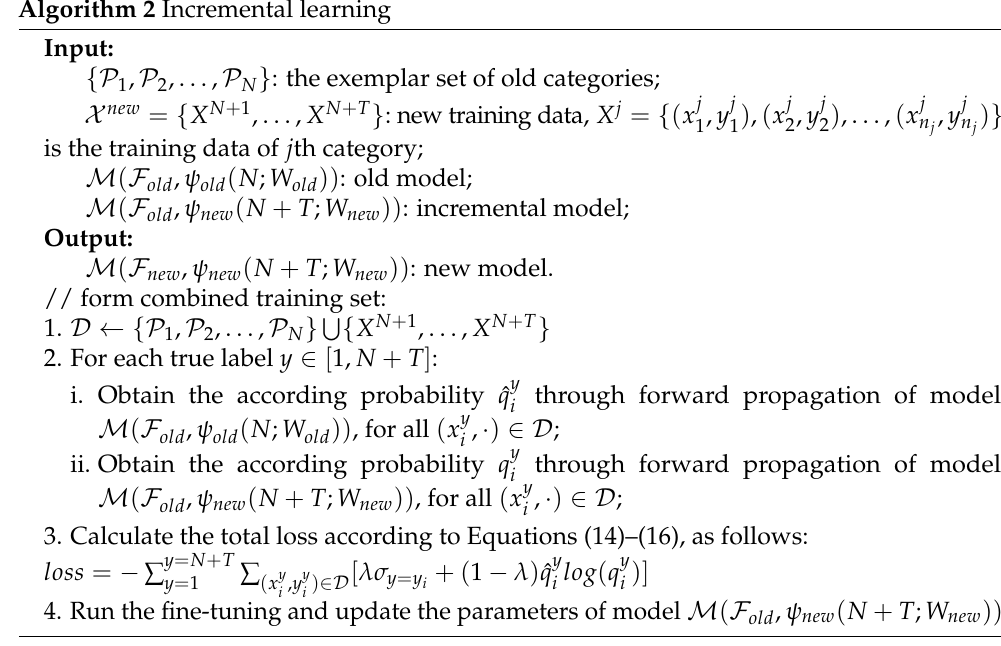
Algorithm 2 Incremental